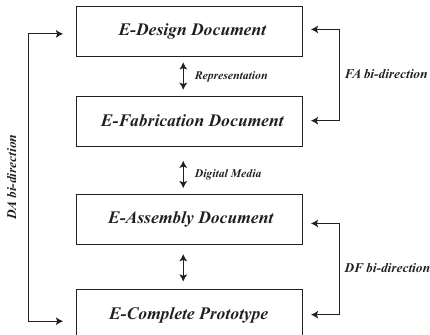
Figure 2. The Design–Fabrication–Assembly (DFA)